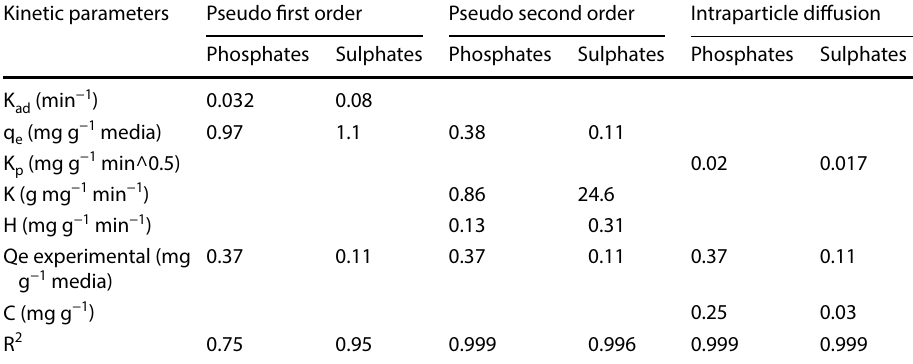
Where K , K q , K , h and C are K 1 2, e p adsorption capacities at equilibrium, K and C is the boundary layer